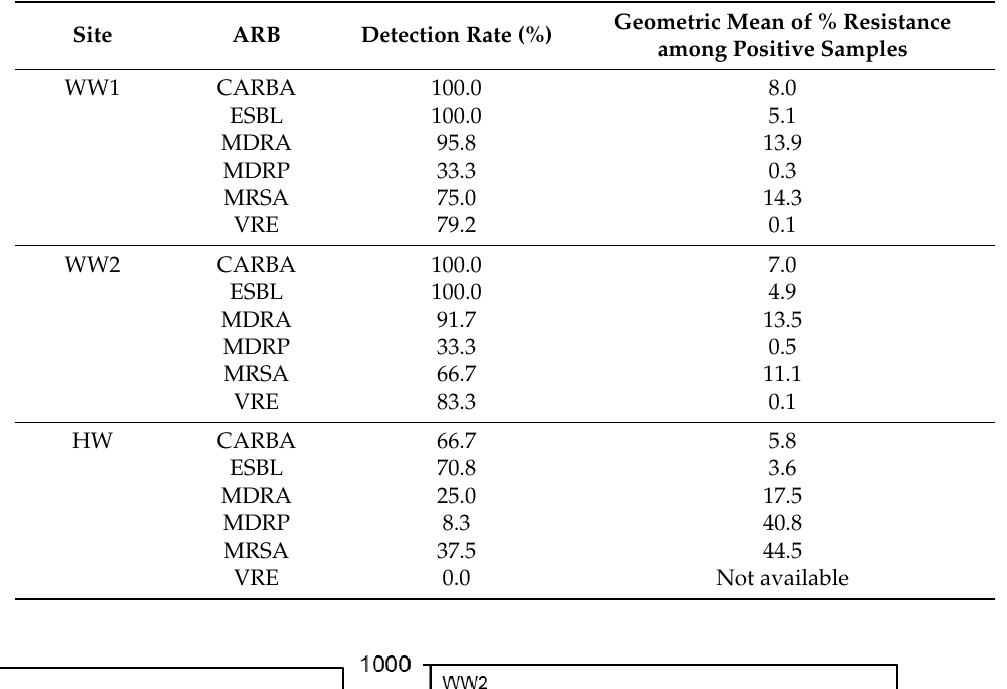
Table 1. Detection rate of each ARB and its geometric mean of %resistance during the one-year study.